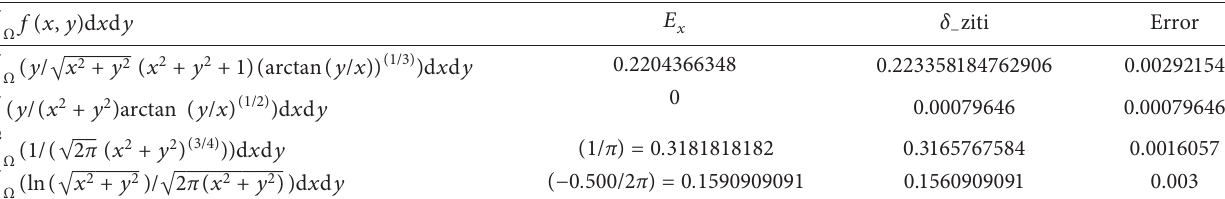
Table 3: Generalized integrals using the polar